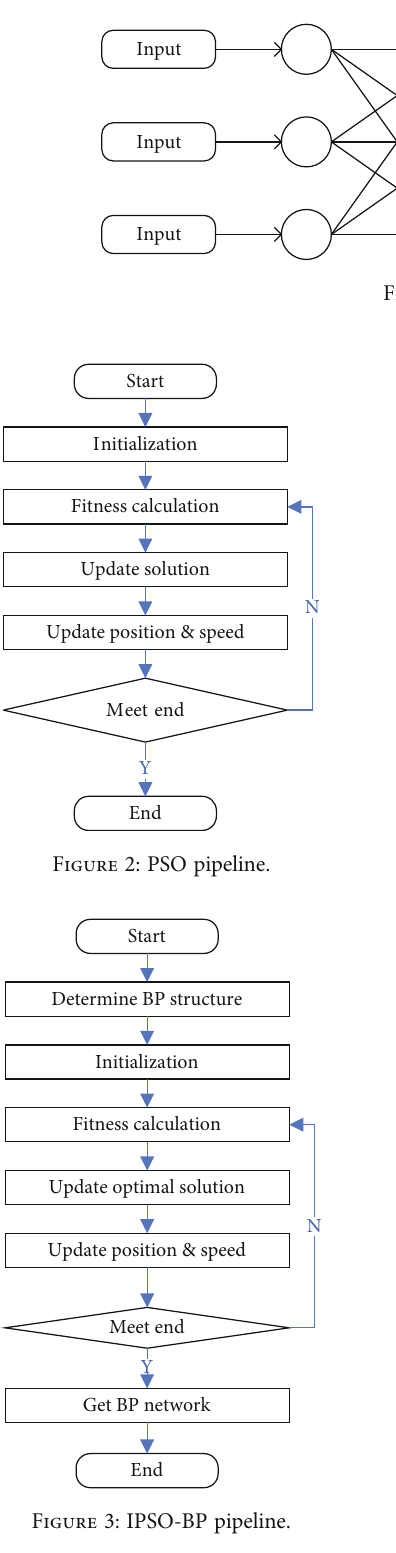
Figure 3: IPSO-BP